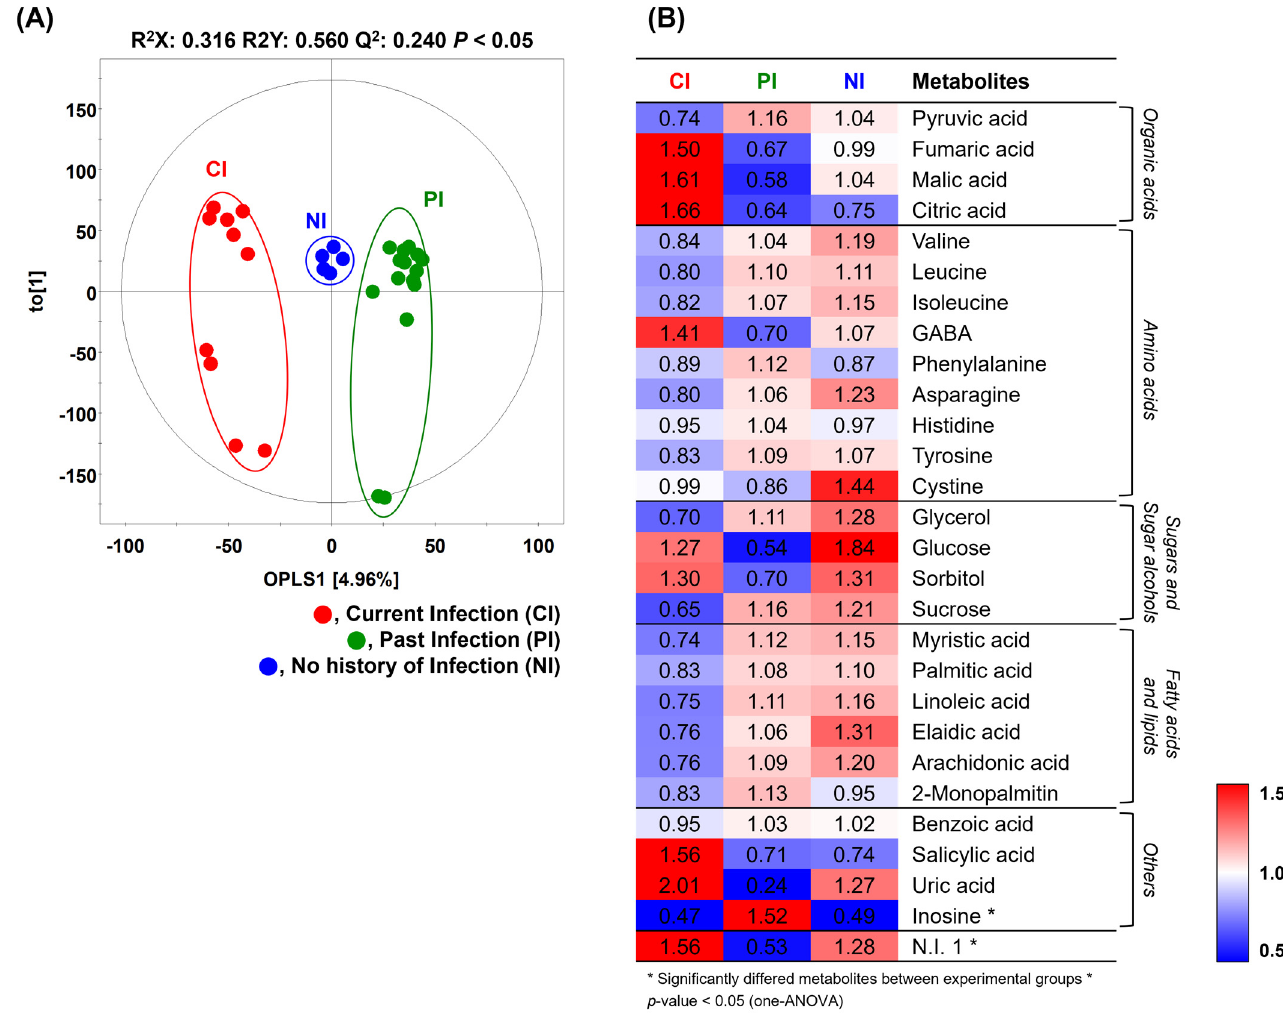
Figure 1. ( A ) Orthogonal partial least discriminant analysis score plots obtained from the GC-TOF-MS dataset of the gastric mucosa samples from three different groups. ( B ) Heat map analysis for the relative abundance of different metabolites (VIP > 1.0) derived from the GC-TOF-MS analysis. The colored squares (blue to red) indicate fold changes normalized by the average of each metabolite. * Significantly different metabolites among the three groups (CI, PI, and NI groups); p < 0.05 using one-way ANOVA.